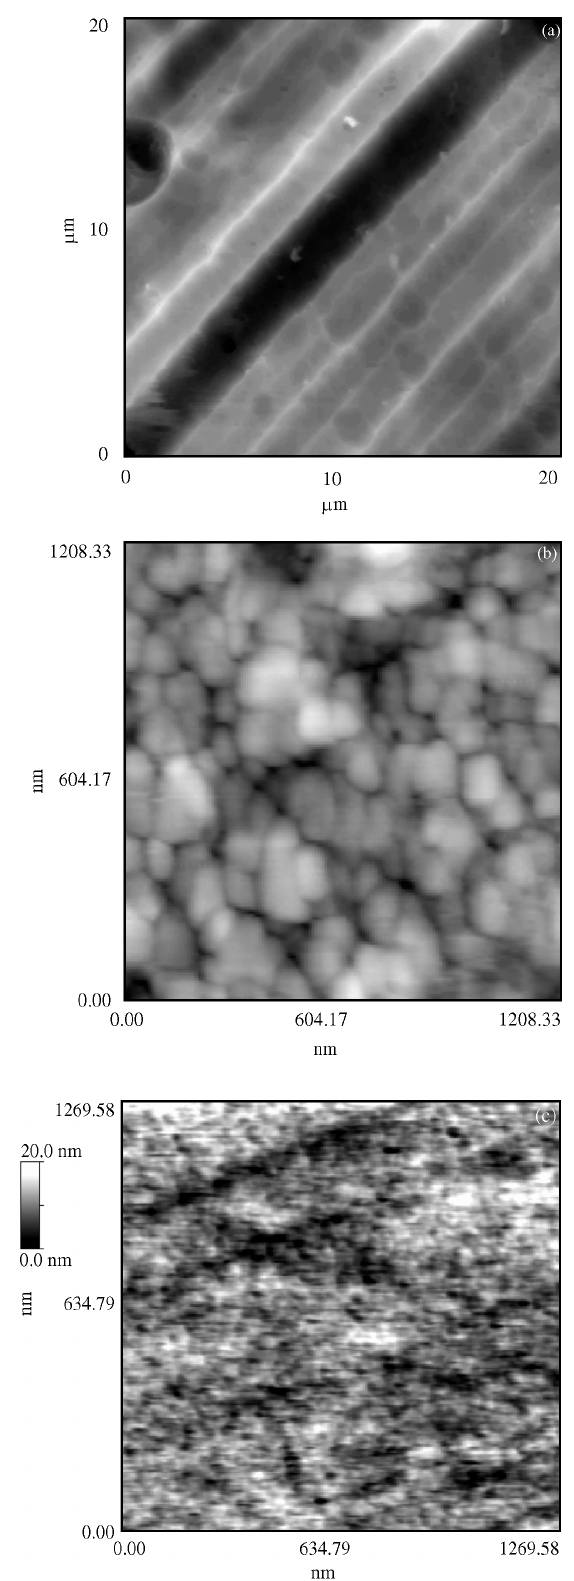
Figure 2. Nyquist diagram of a TiC x N y film/M2 high speed steel substrate system as a function of the exposition time to the Na 2 SO 4 0.5M